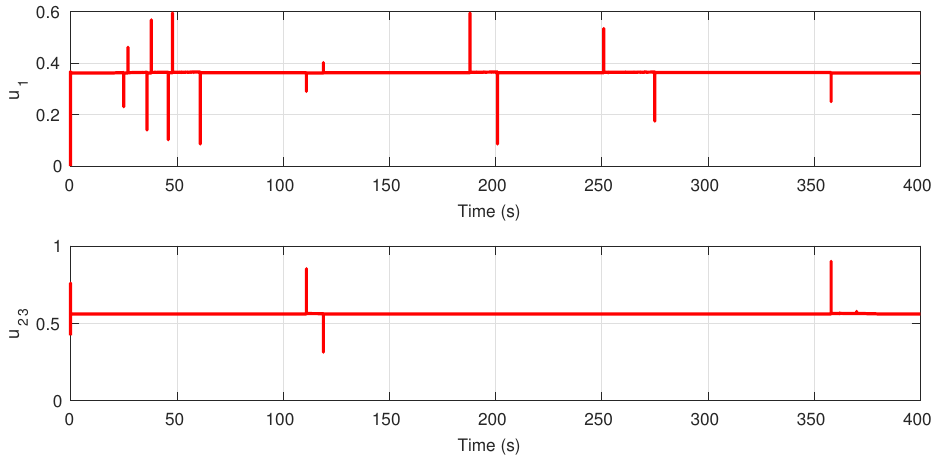
Figure 5. Time responses of inputs for the backstepping-based adaptive